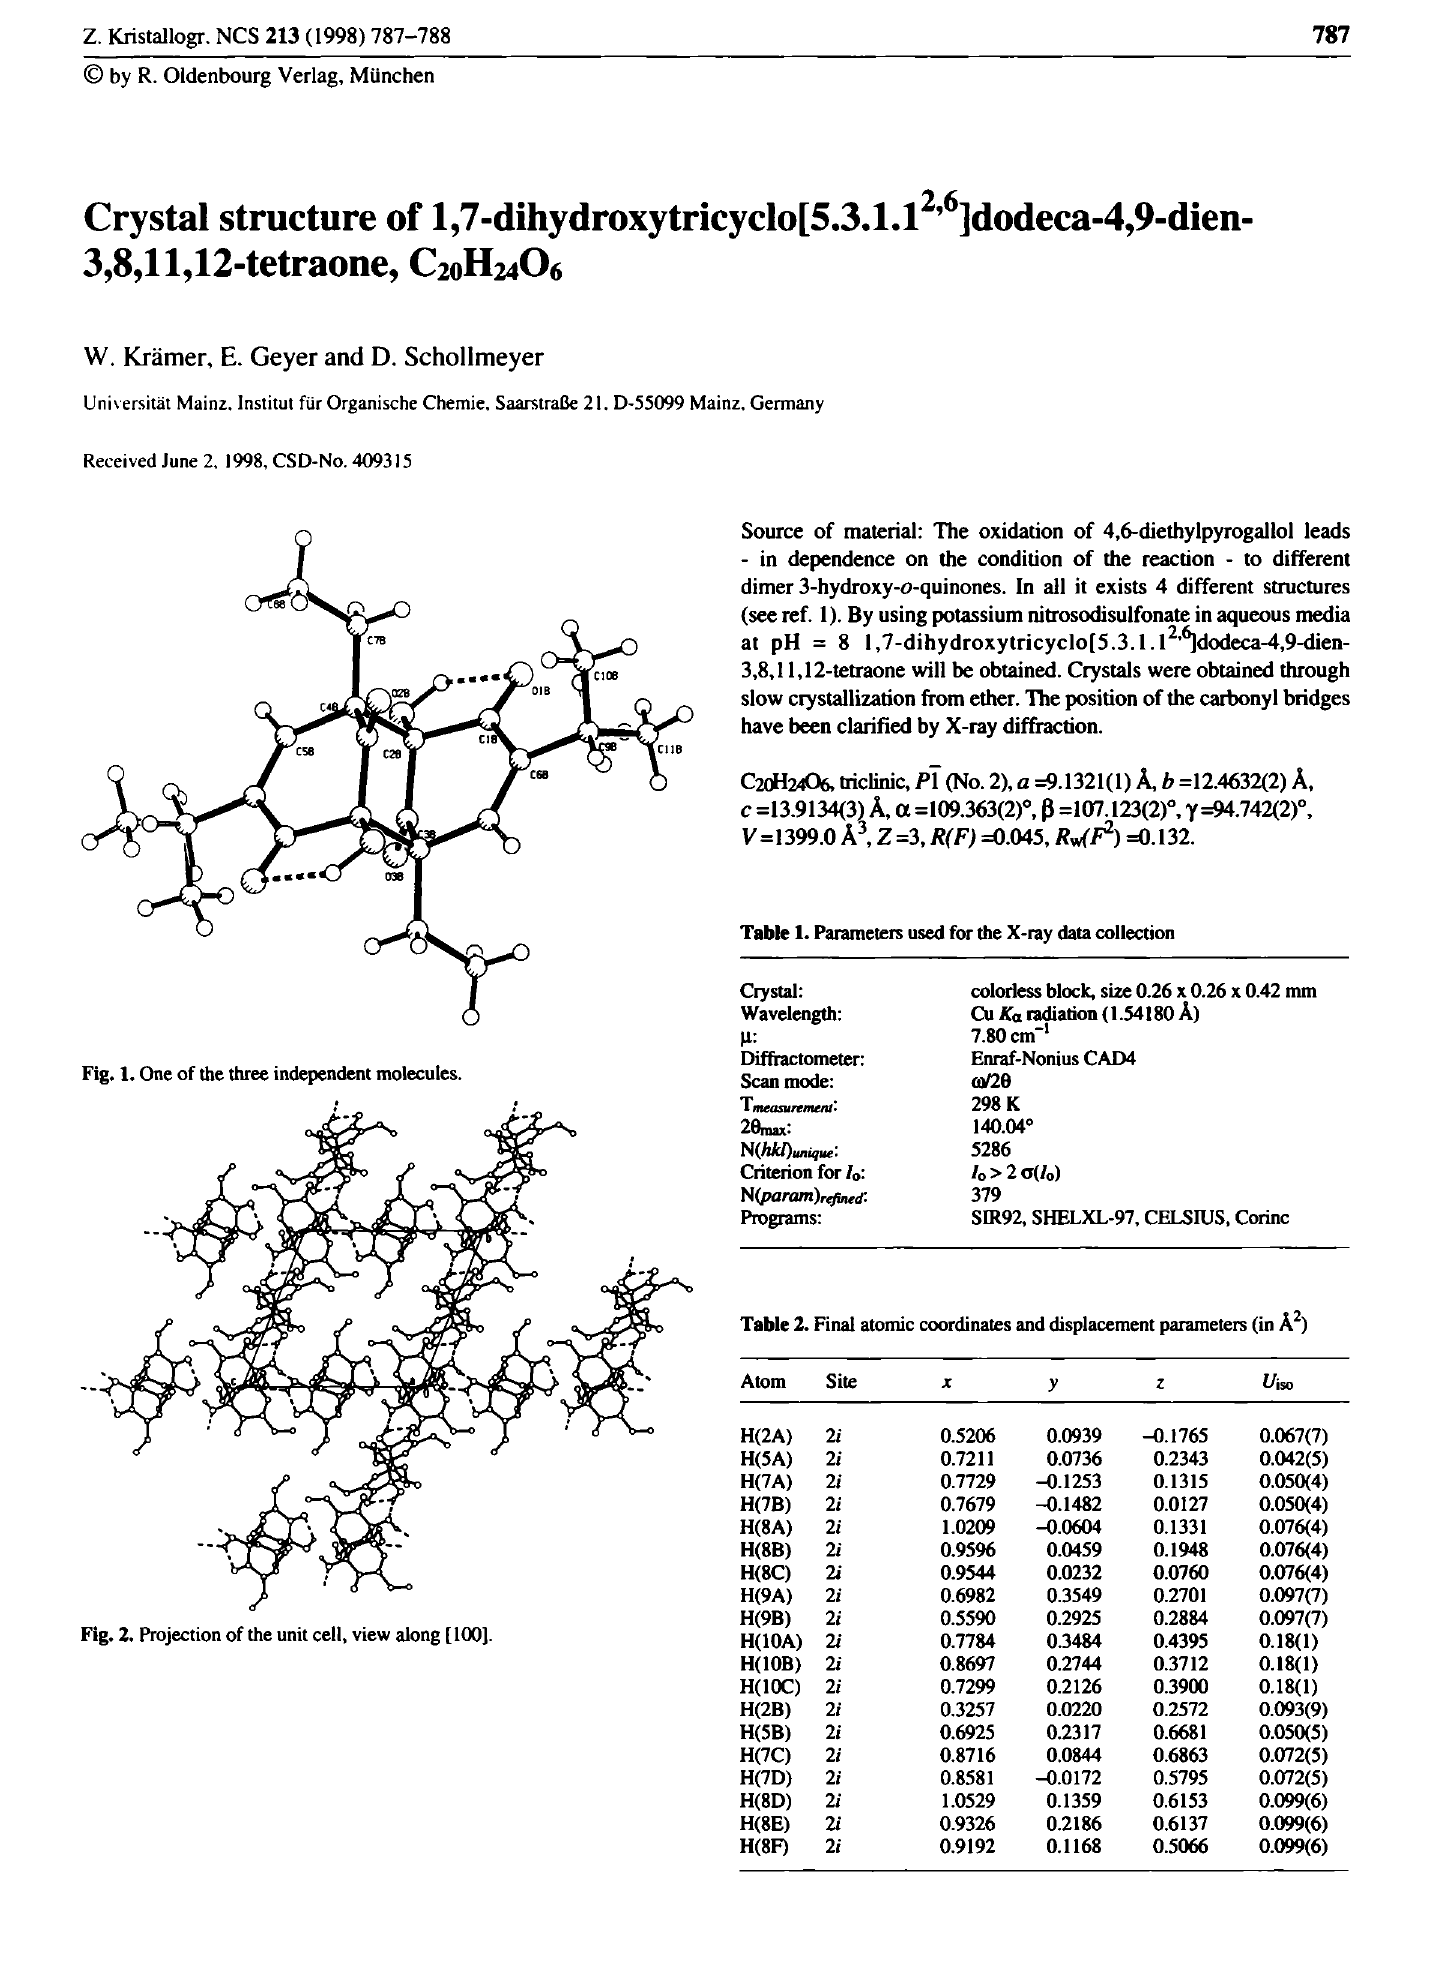
Fig. 2. Projection of the unit cell, view along [100].